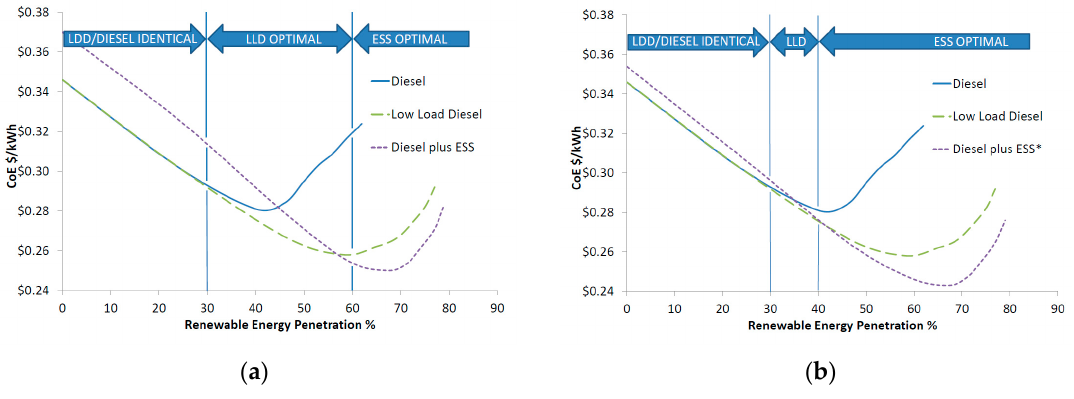
Figure 3. ( a ) CoE as a function of RE penetration for diesel, LLD and diesel plus ESS; ( b ) CoE for reduced ESS pricing, as a function of RE penetration for diesel, low load diesel and diesel plus energy storage architectures. At sufficient (>50%) ESS discount LLD benefit becomes marginal.